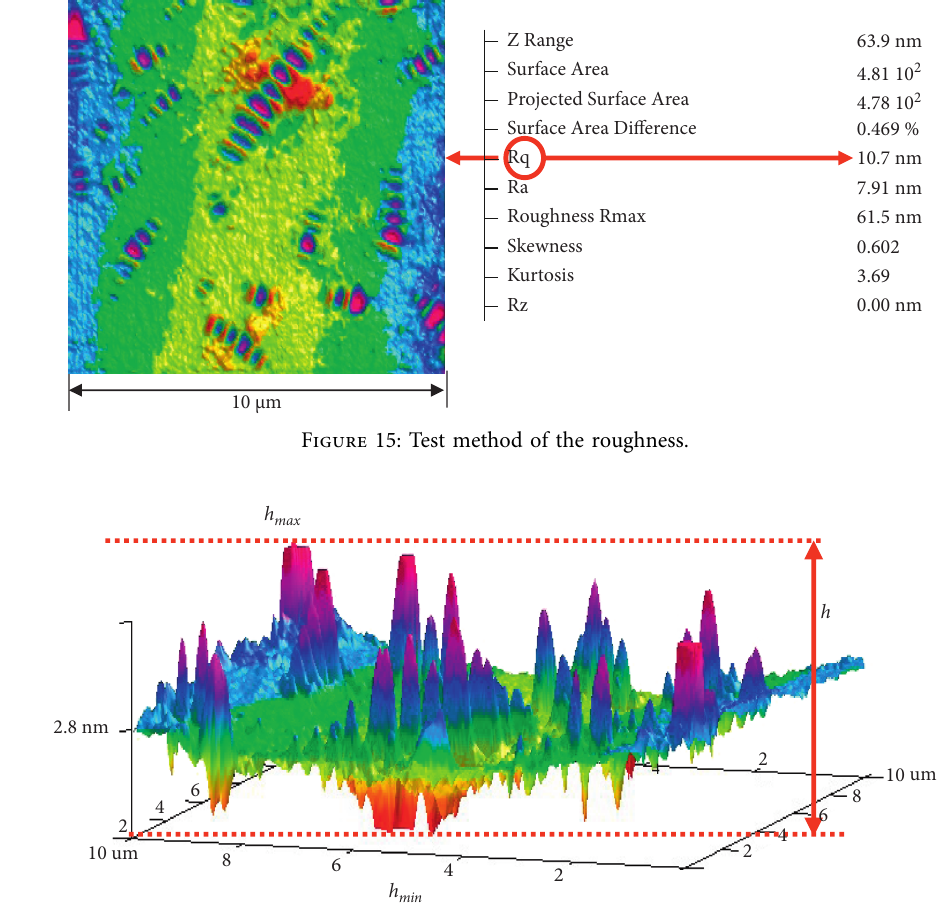
Figure 16: Test method of the maximum